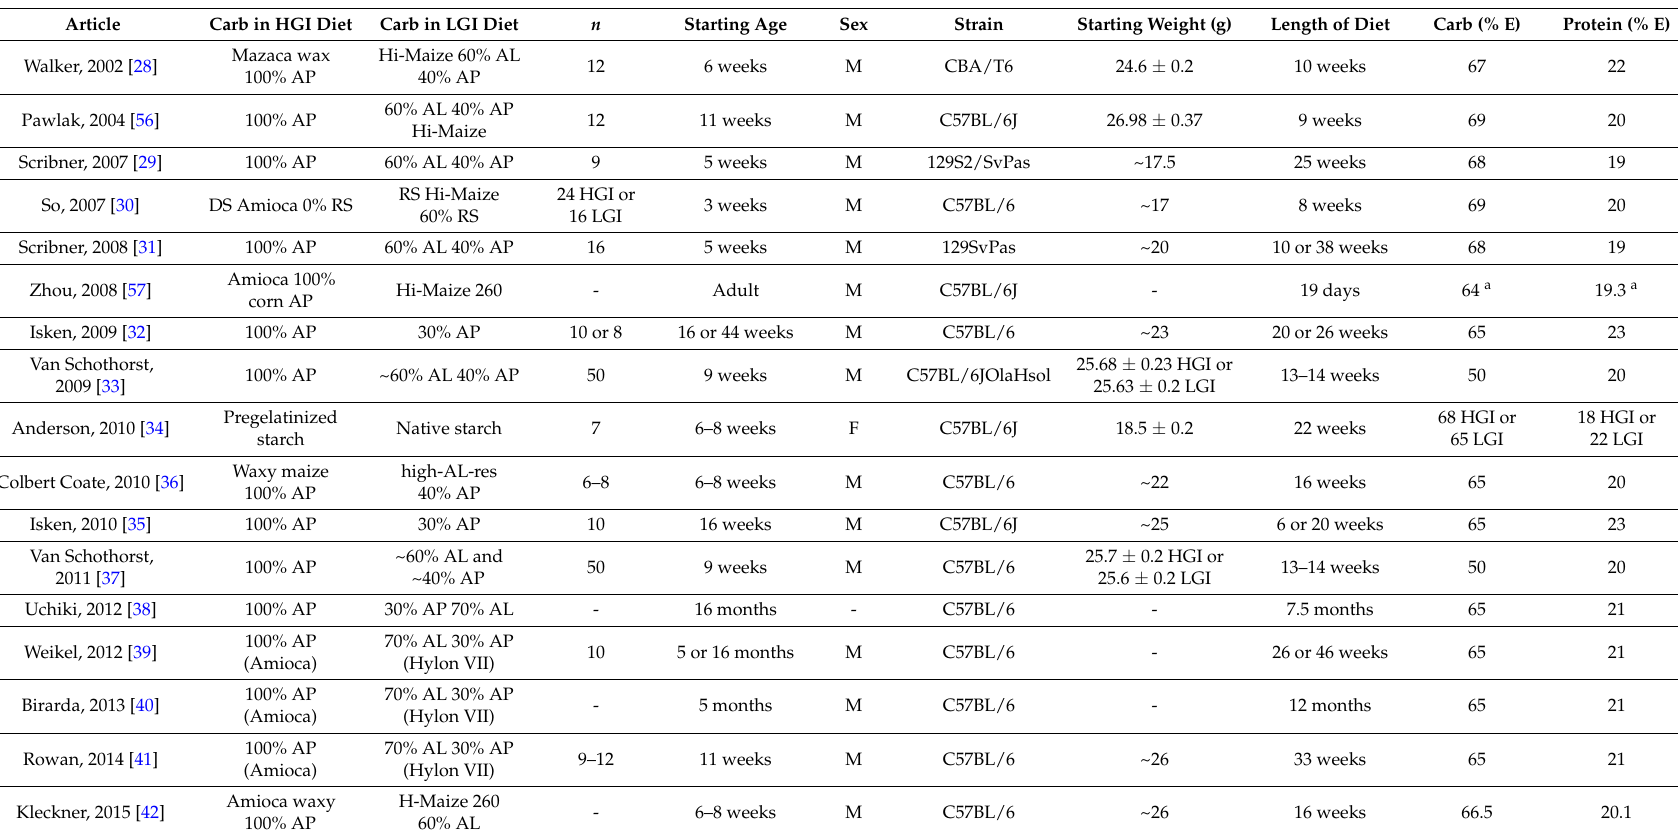
Table 4. Mouse animal and diet characteristics for intervention studies that compared LGI and HGI diets. The key information from each article using mice is shown. - denotes missing data. Approximate (~) starting weights are taken from graphs a . Carb, carbohydrates; HGI, high glycaemic index; LGI, low glycaemic index; E, energy; n , sample size; AP, amylopectin; AL, amylose; M, male; DS, digestible starch; RS, resistant starch; F,